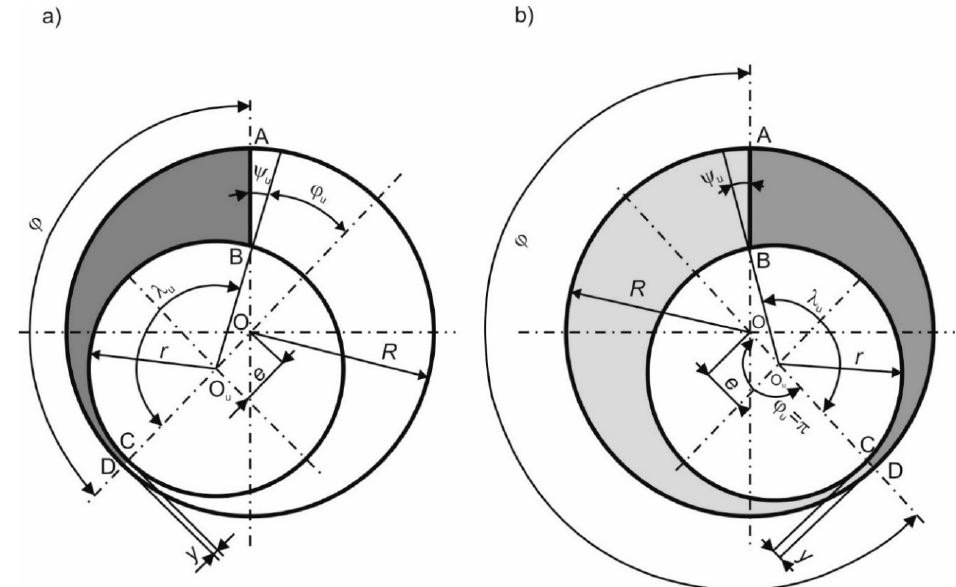
Figure 5. The scheme used for determination of the working chamber volume. ( a ) π > ϕ > 0; ( b ) 2 π > ϕ > π .